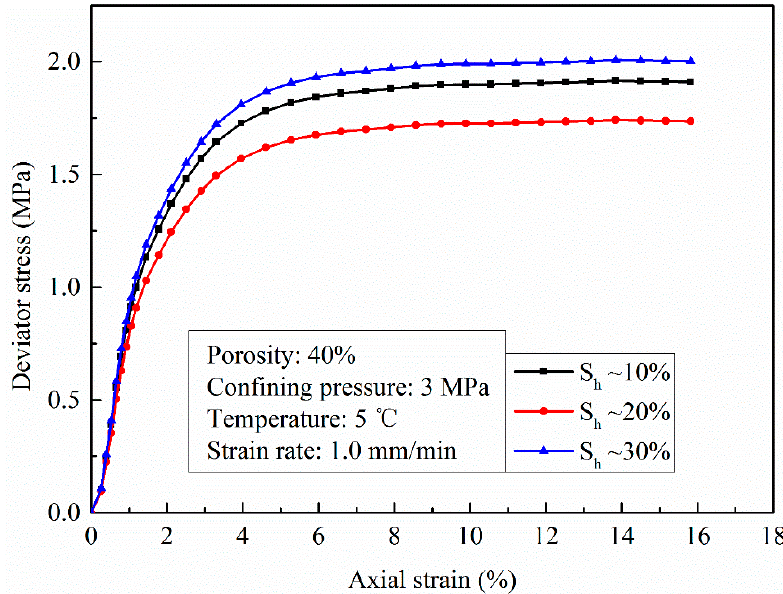
Figure 9. Stress–strain curves of HBMS with different hydrate saturations.